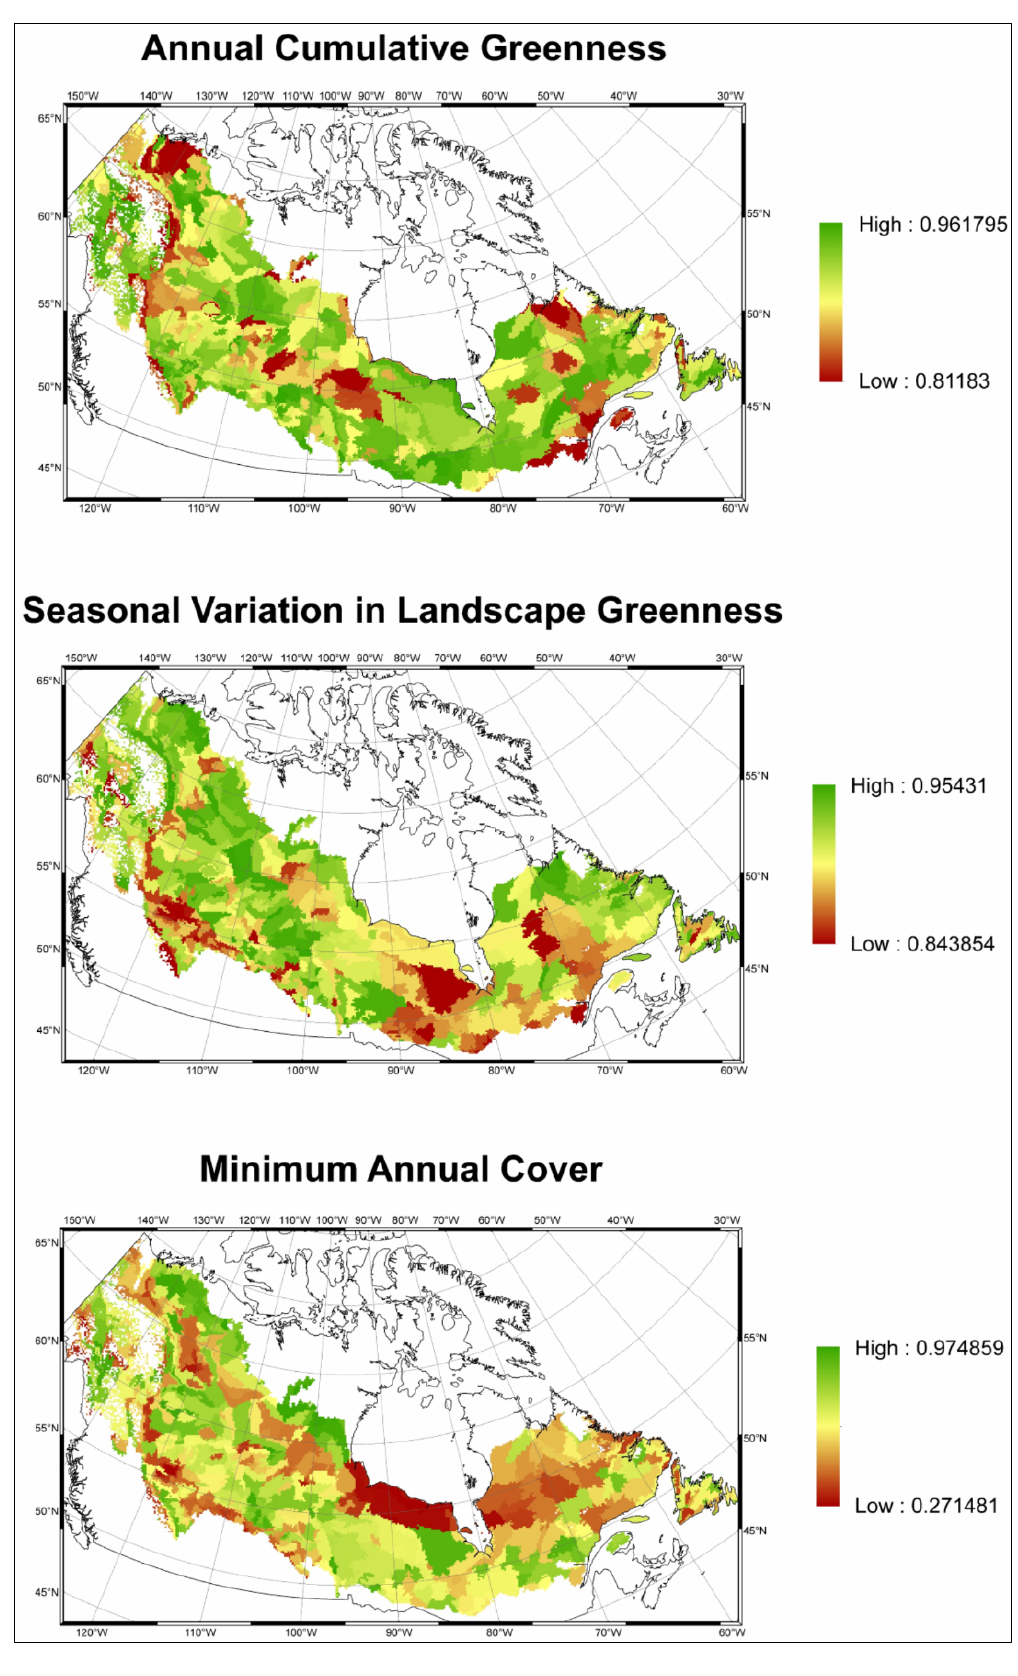
Figure 7. Map comparison results comparing modelled and observed DHI components in 2007. Values are an average of map comparison values for each ecozone, where high values indicate more similarity between observed and modelled